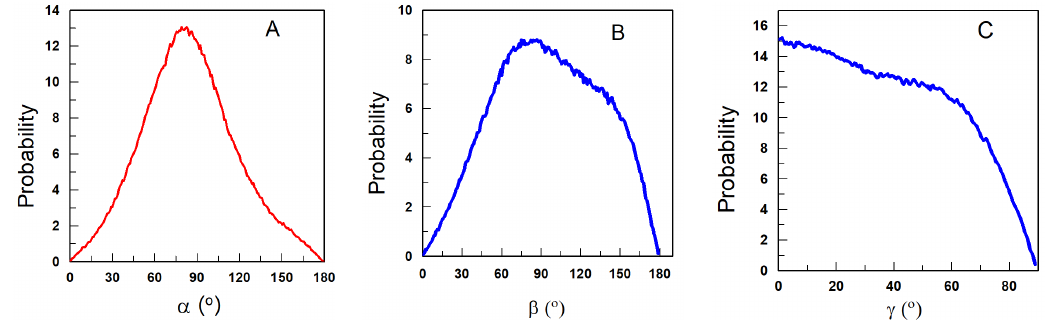
Figure 7. Orientation of gallic acid as defined by angles α ( A ), β ( B ) and γ ( C ).